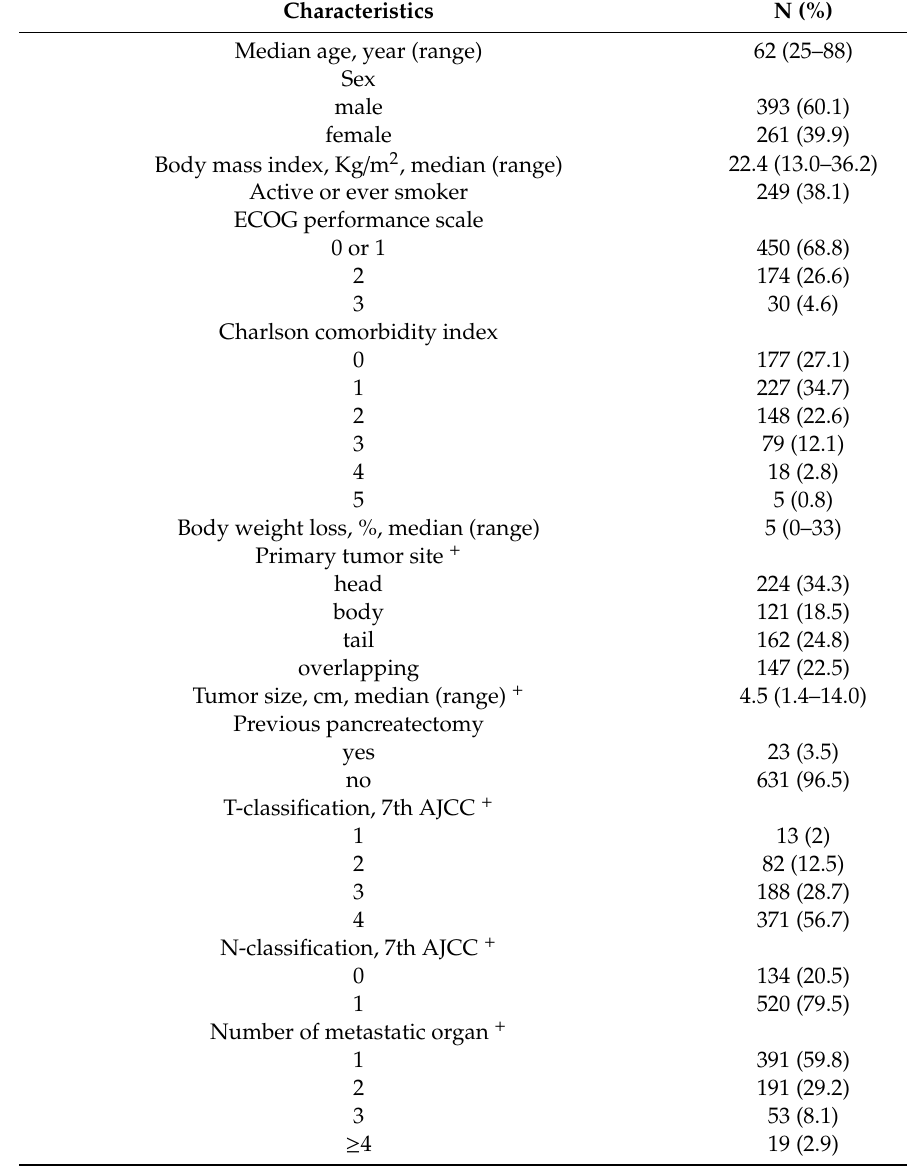
Table 1. Patient’s basic